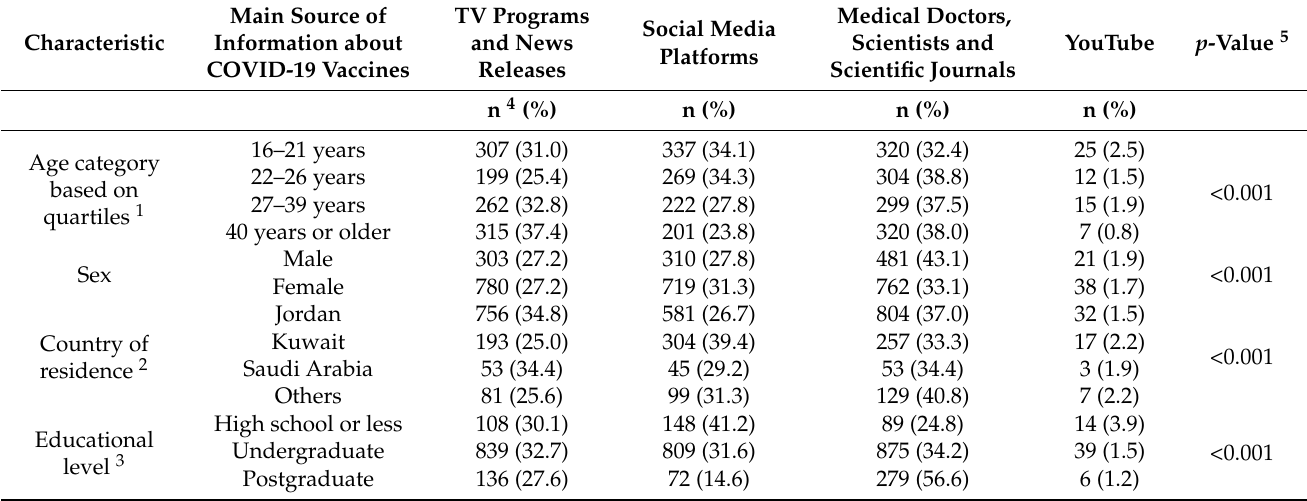
Table 5. The main sources of information regarding COVID-19 vaccines stratified by respondent demographics.